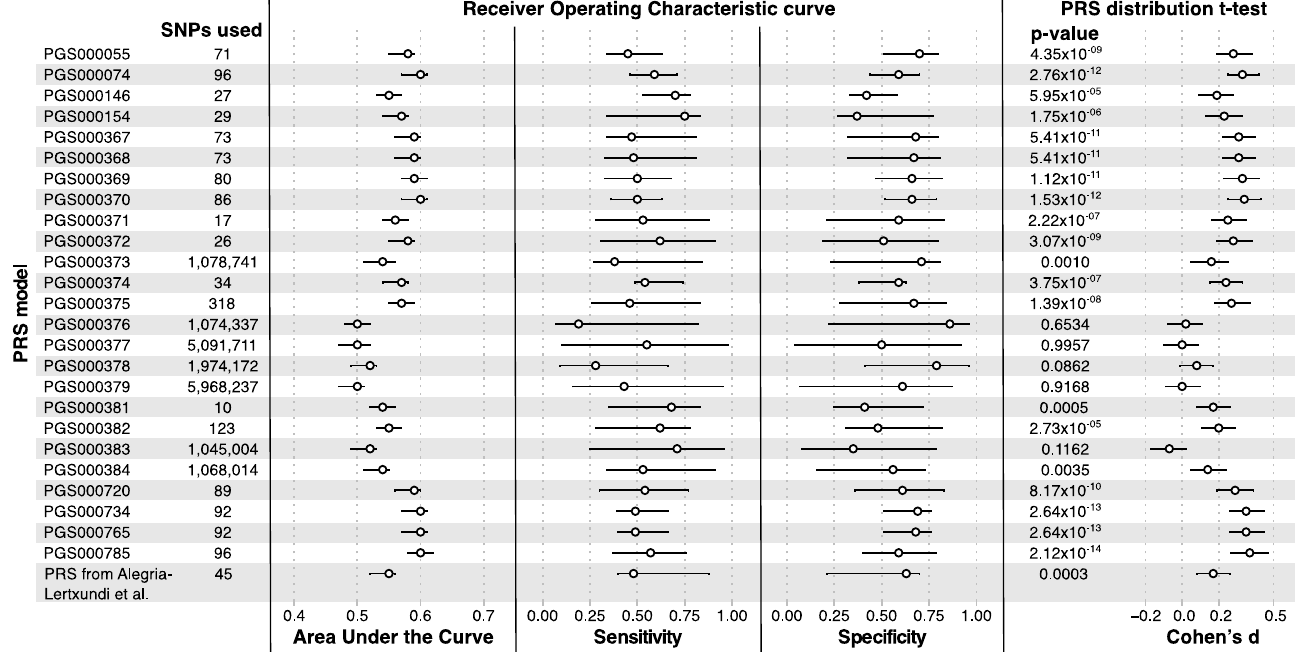
Figure 2. Performance of different Polygenic Risk Score sets. For each parameter, the value and 95% of confidence interval are depicted. Cohen’s d, the effect size of the T-test and 95% of the confidence interval, < 0.2 negligible effects, 0.2–0.5 small effect, 0.5–0.8 moderate effect, > 0.8 large effects.